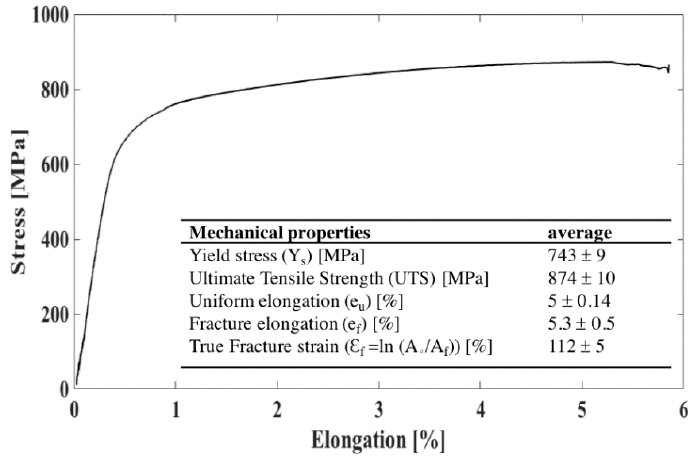
Figure 3. Engineering stress and elongation curve with corresponding tensile properties .